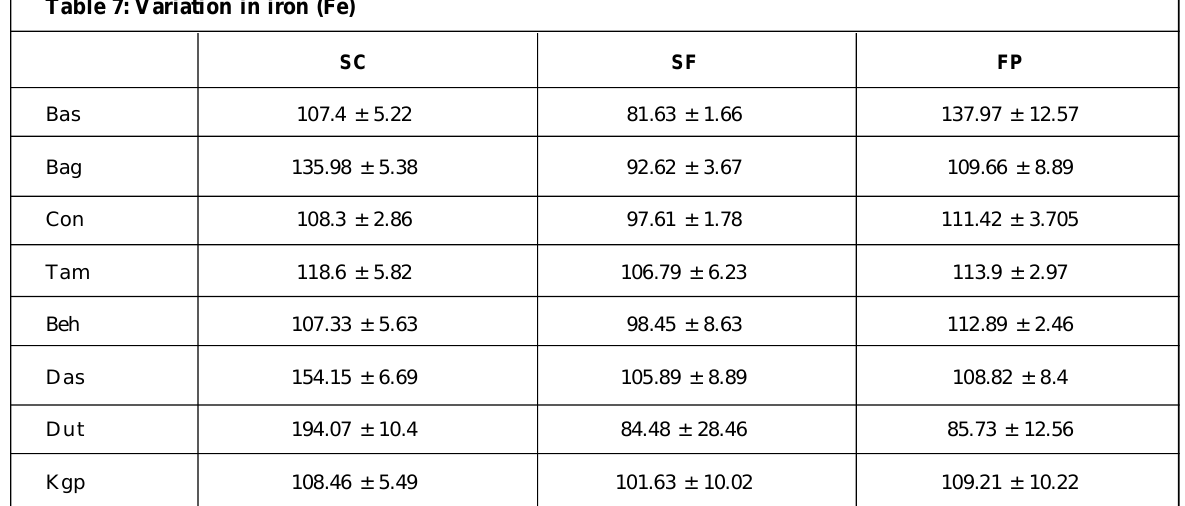
Table 7: Variation in iron